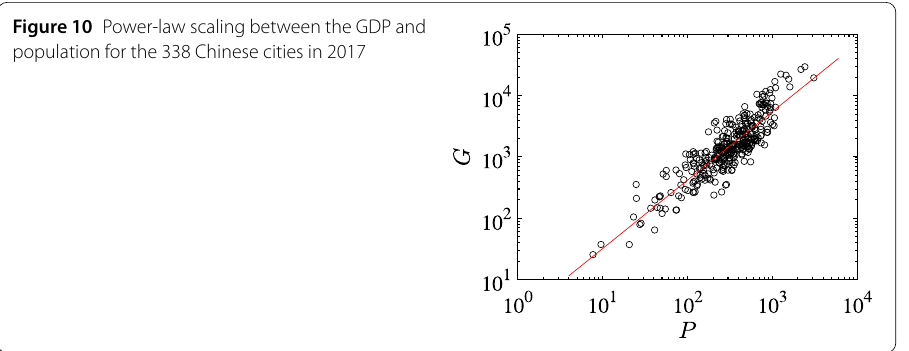
Figure 10 Power-law scaling between the GDP and population for the 338 Chinese cities in